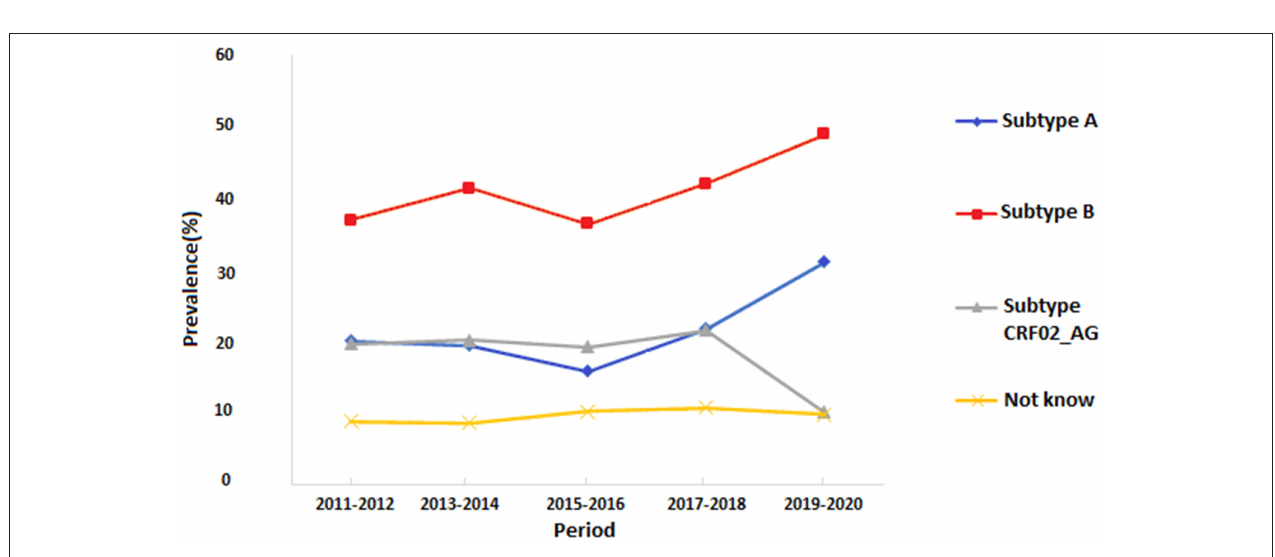
FIGURE 3 | Trends of the prevalence of different HIV-1 subtypes in Libya during the armed conflict of